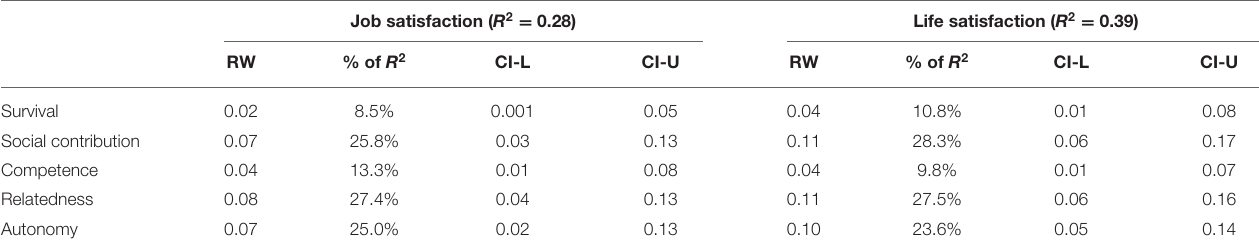
TABLE 5 | Relative weight analysis for concurrent validity ( N = 250